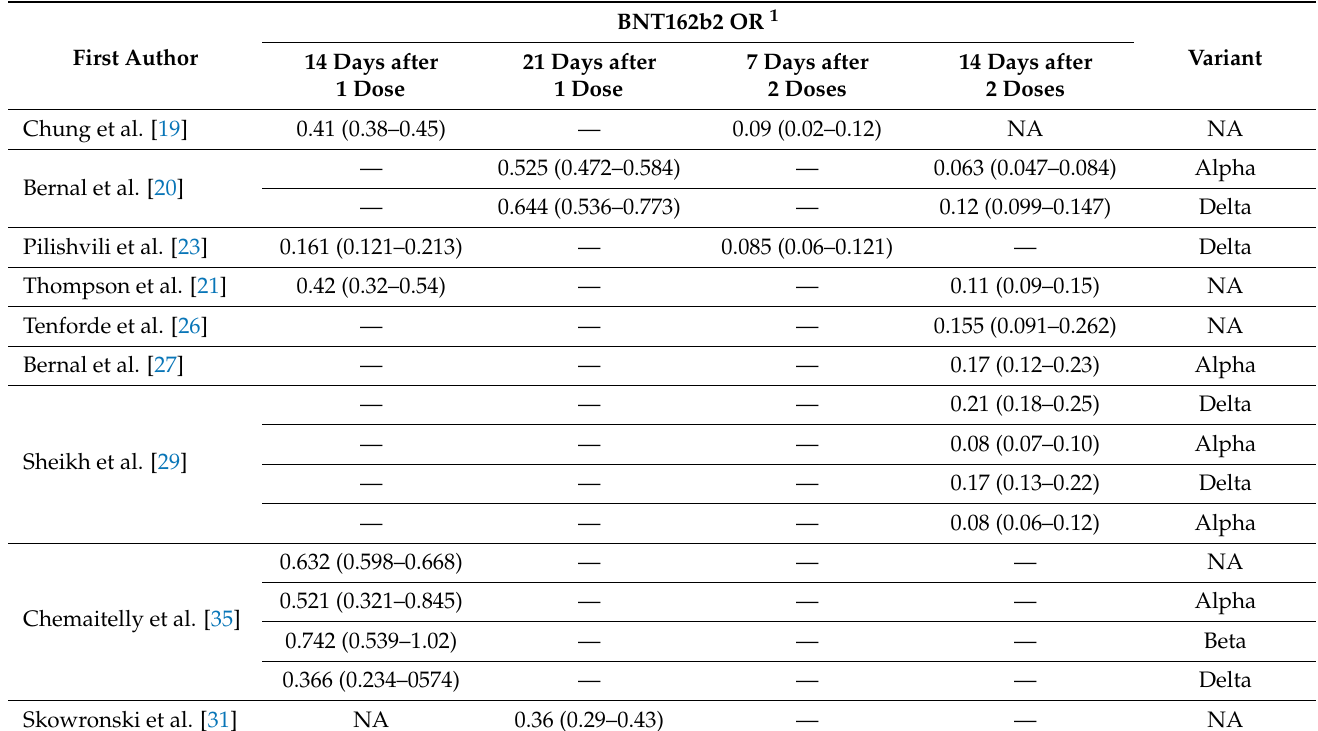
Table 2. Effectiveness of the BNT162b2 vaccine against SARS-CoV-2 infection after 1 dose and after 2